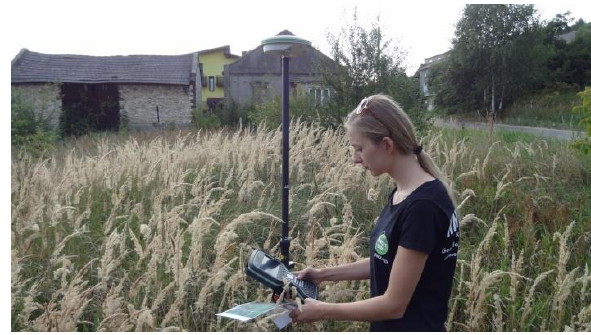
Figure 2. Collection of reference plot locations—plot for Calamagrostis epigejos shown in above picture.